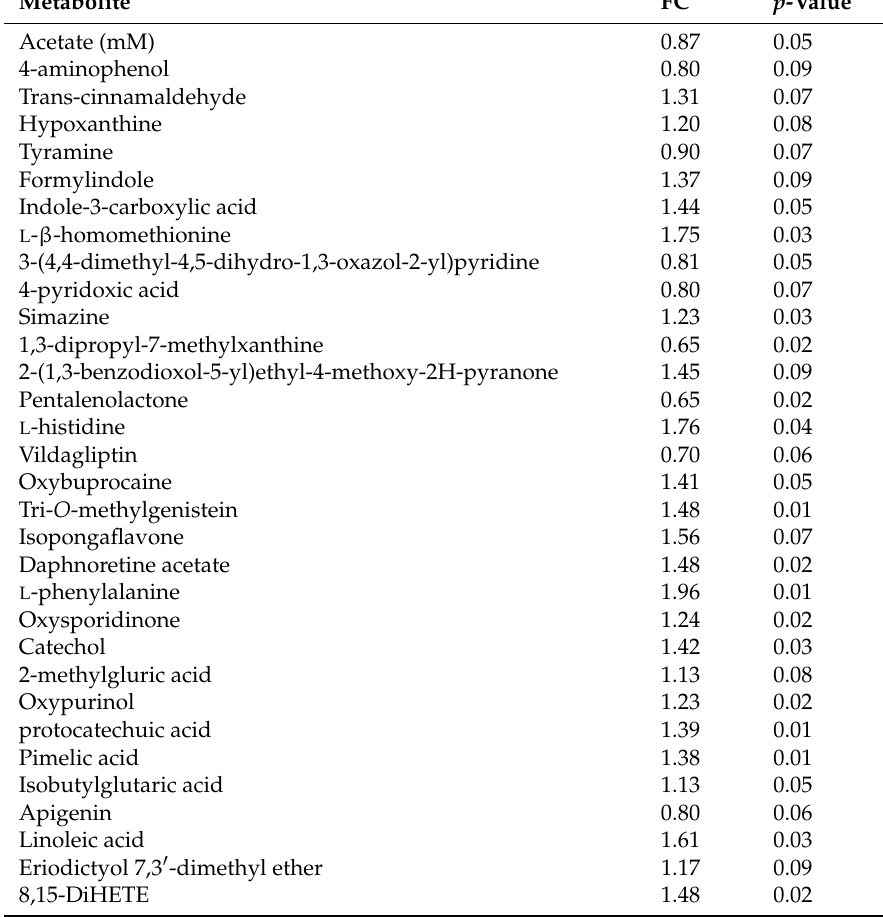
Table 1. Fold changes of differential rumen fluid metabolites in beef steers fed no or 200 mg d − 1 of monensin.